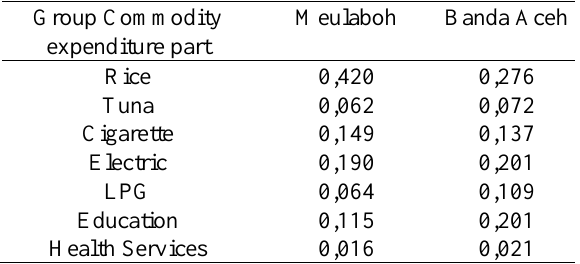
Table 3 Commodity contributor to inflation in Aceh (Banda Aceh,